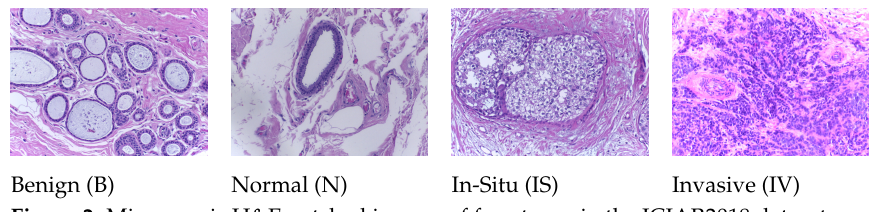
Figure 2. Microscopic H&E patched images of four types in the ICIAR2018